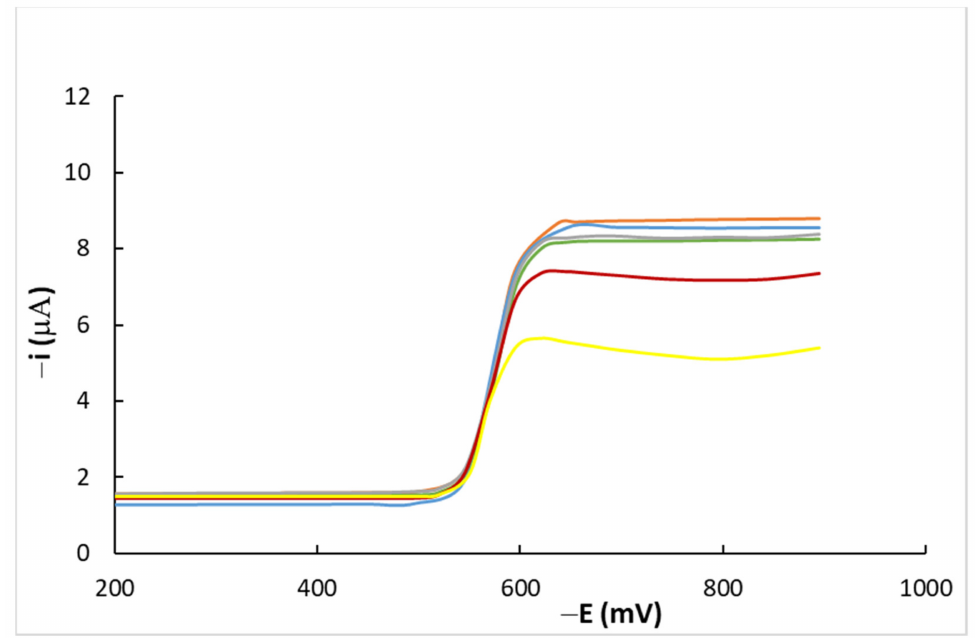
Figure 1. Polarograms for Cd(II) in the presence of TEA in 0.55 M perchloric acid solutions. TEA concentrations (mM): 0 (orange), 0.75 (blue), 2 (green), 5 (grey), 10 (red), 20 (yellow).